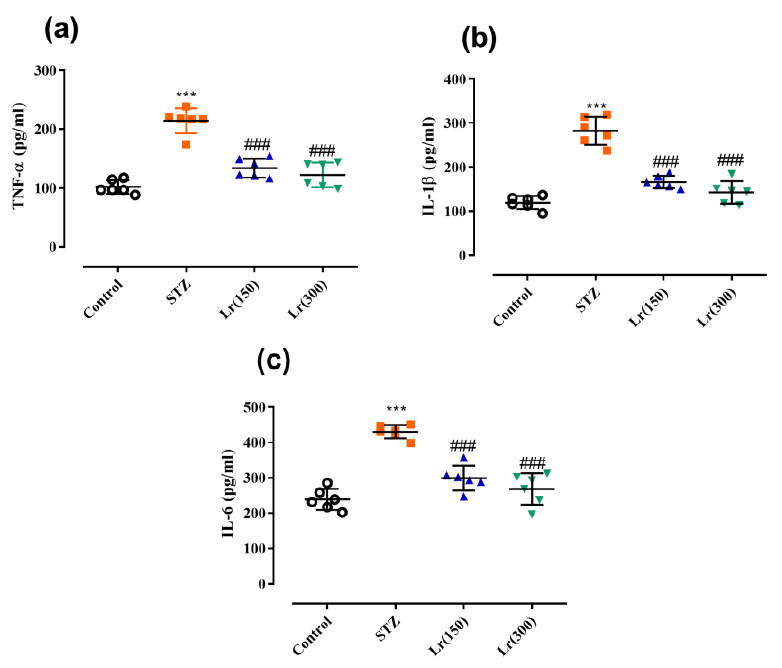
Figure 3. Effect of L. regularis (150 or 300 mg/kg for 4 consecutive weeks) on diabetic-induced changes in serum proinflammatory cytokines, including tumor necrosis factor- α (TNF- α ) ( a ), interleukin-1 β (IL-1 β ) ( b ) and interleukin-6 (IL-6) ( c ). Data are expressed as means ± SE ( n = 6) and were analyzed using one-way ANOVA followed by Student Newman–Keuls as post hoc test. * Control vs. STZ group; # STZ vs. L. regularis (150) or L. regularis (300). *** or ### p < 0.001.